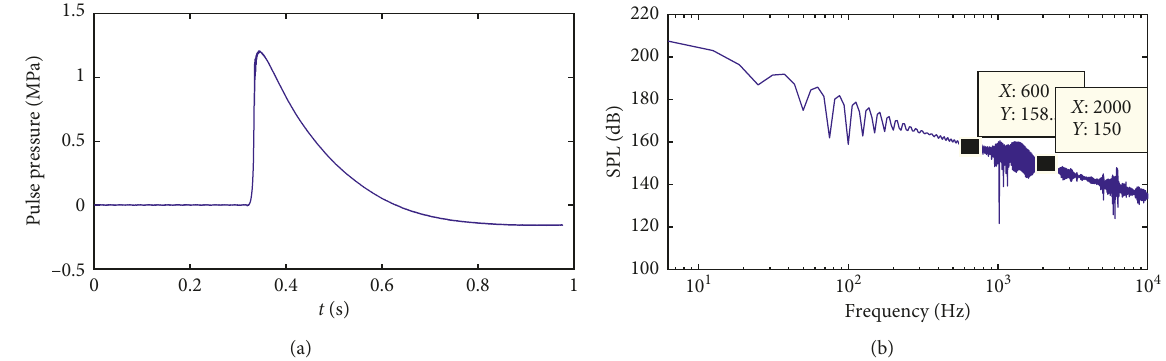
Figure 8: Cylinder pulse pressure. (a) Time domain signal and (b) amplitude-frequency curve.